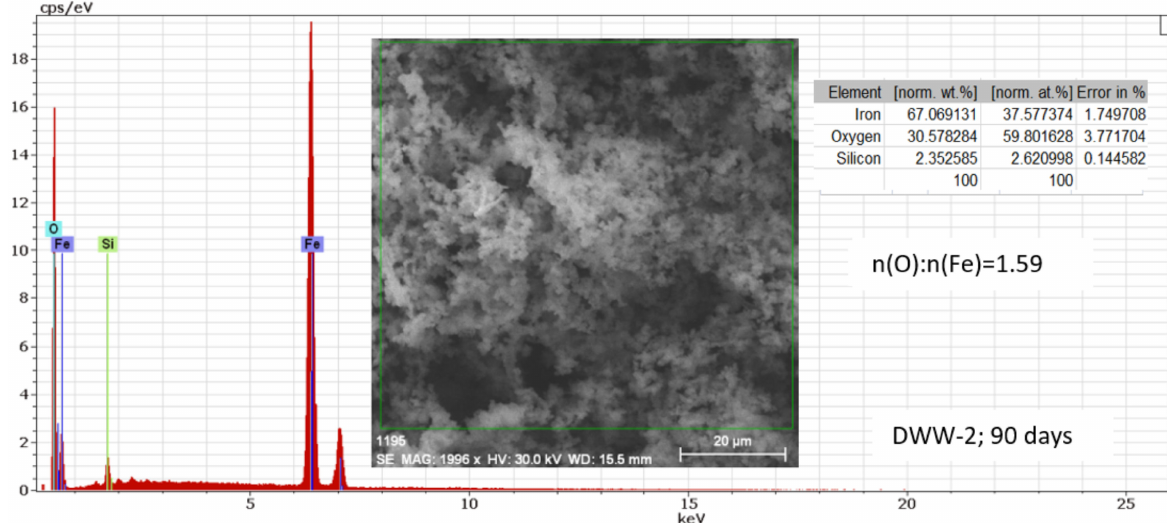
Figure 26. EDS results for the sample immersed for 90 days in